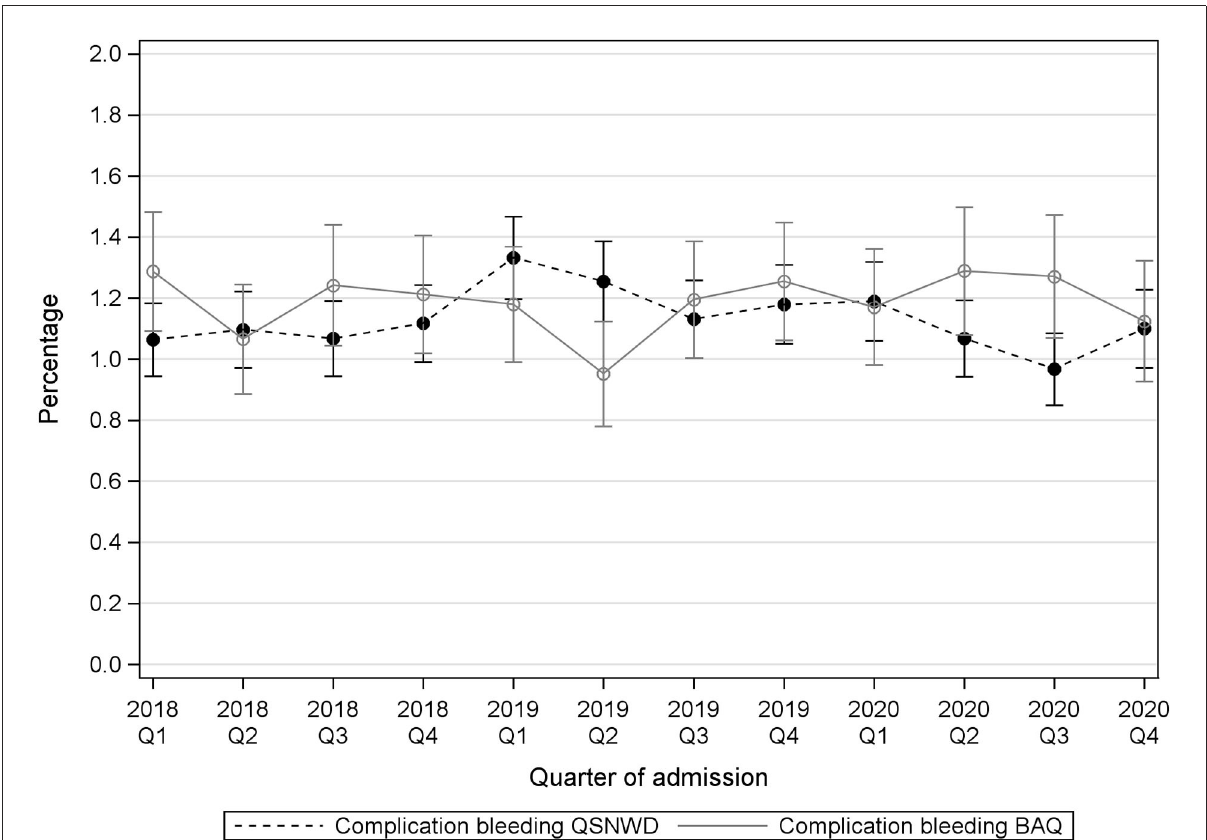
FIGURE5 Complication bleeding of all included patients from the registries QSNWD (dashed line) and BAQ (solid line) in 2018-2020 by quarter of